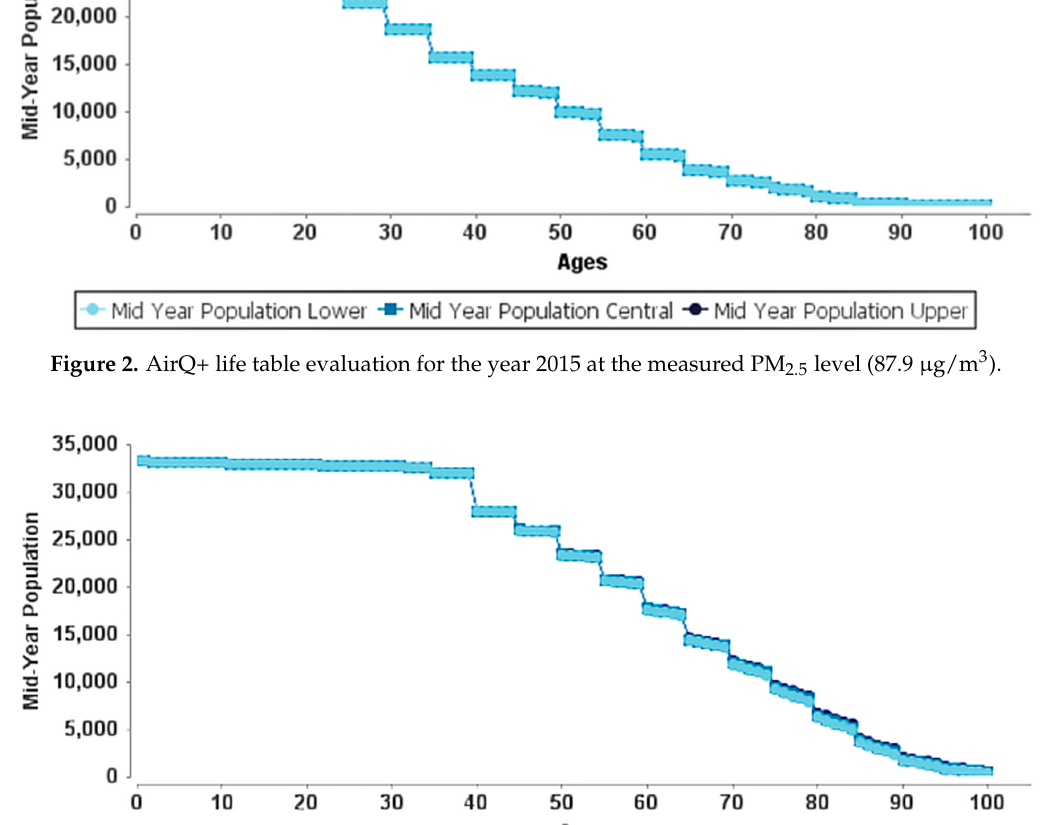
Figure 3. AirQ+ life table evaluation for the year 2045 (30-year forecast) if PM 2.5 is reduced to the cut-off level (35 μ g/m 3 ).